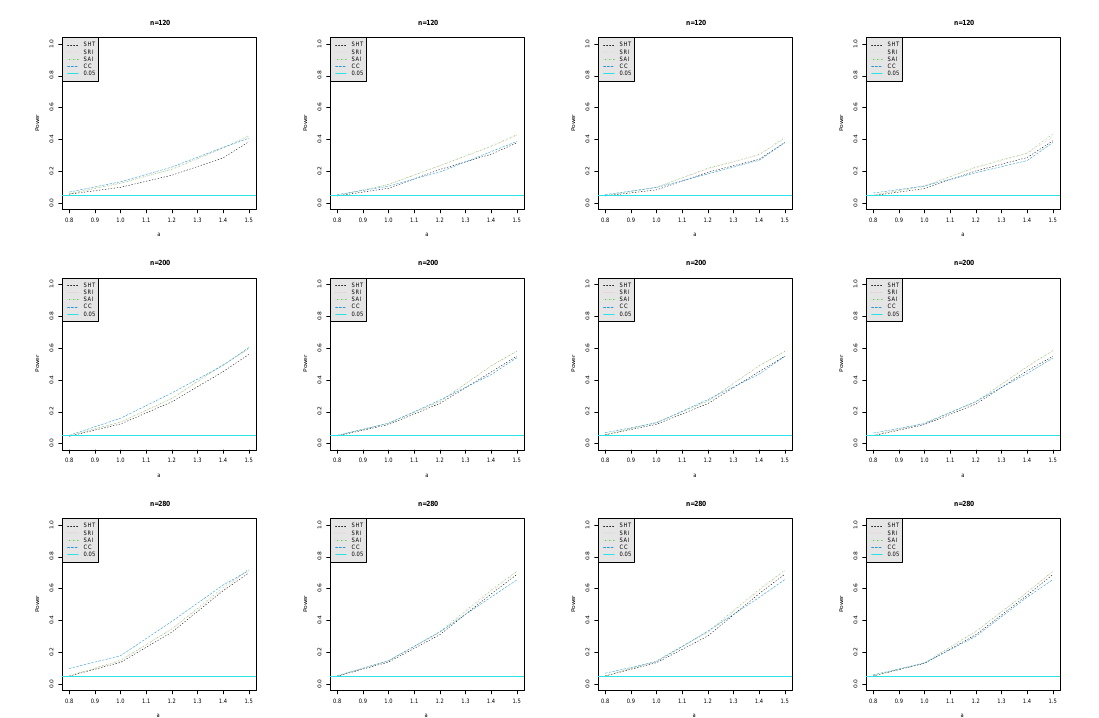
Figure A2. SHT, SRI, SAI and CC represent empirical powers evaluated from IPW, regression imputation, AIPW and CC methods against a for missingness data mechanism models E1 (left panel), E2 (left second panel), E3 (right second panel) and E4 (right panel) for N = 120 (the first row), 200 (middle row) and 280 (the last row) under the unbalanced designs with n E : n R : n P = 2:1:1. Figure A3 presents empirical powers against the sample size n for missingness data mechanism models E1–E4 under balanced design for a = 0.4 and 0.6. Figure A4 presents empirical powers against the sample size n for missingness data mechanism models E1–E4 under unbalanced design with n E : n R : n P = 2:1:1. a=0.4